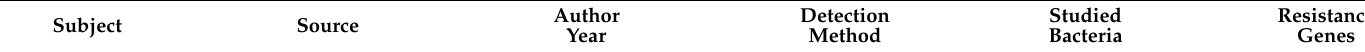
Table 1. Overview of antimicrobial resistance and antimicrobials in wastewater in